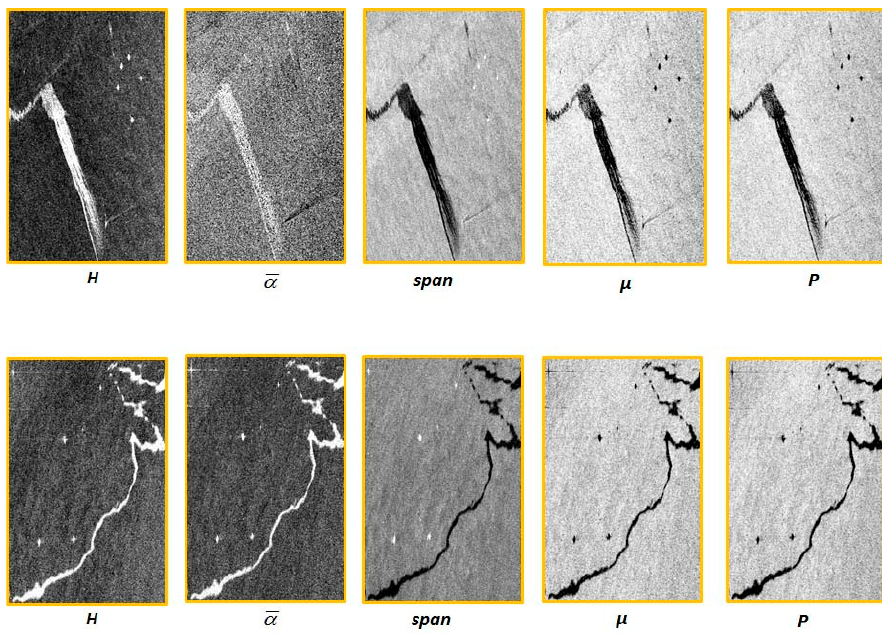
Figure 2. Presentation of several fully Pol-SAR features of Dataset 1 and Dataset 2.